Question: Judging by this figure, is the value going up or going down?
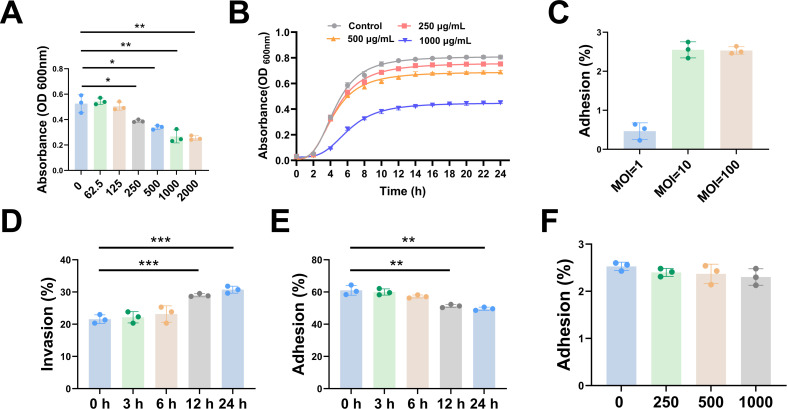
Answer: increasing